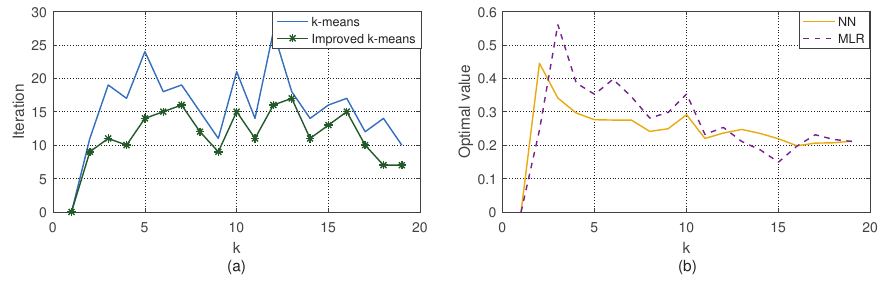
Figure 8. ( a ) The iterations in traditional and improved k-means . ( b ) The curve of determining the optimal number of clusters.